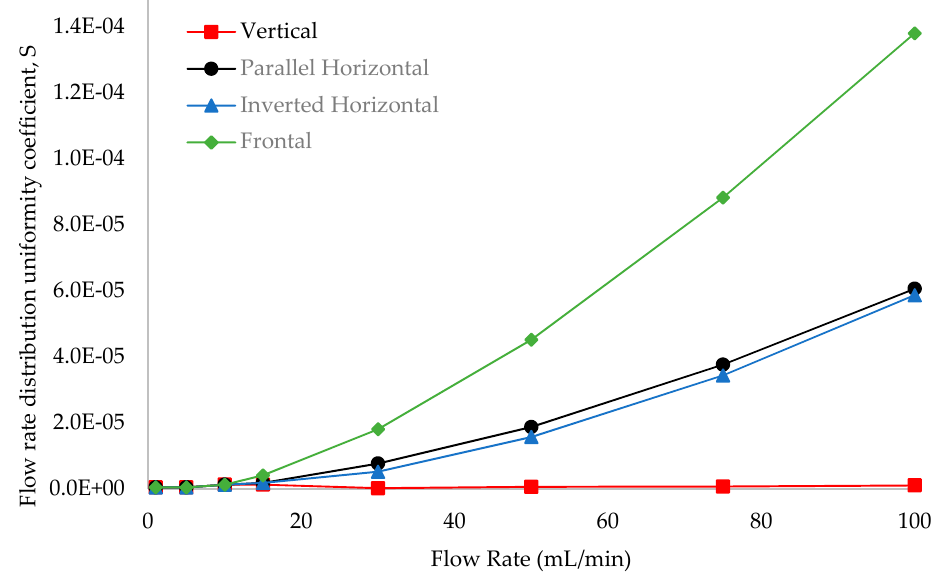
Figure 11. Coefficient of the uniformity distribution of the flow for different heat sink configura- tions.